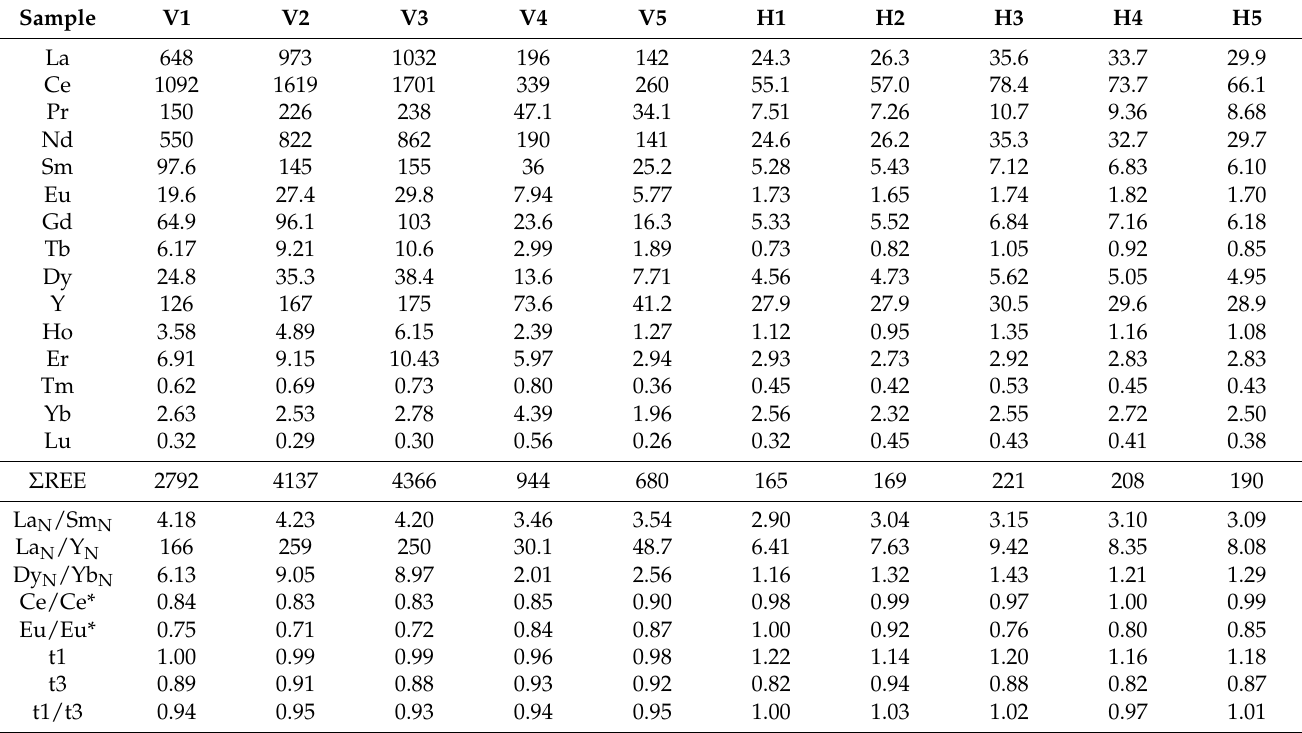
Table 2. Representative whole rock REE contents of the synchysite-bearing quartz–carbonate–sulfide vein (V) and data for the host rocks (H) in the Rožn á uranium deposits. Data are in ppm. For an explanation of symbols, see Table